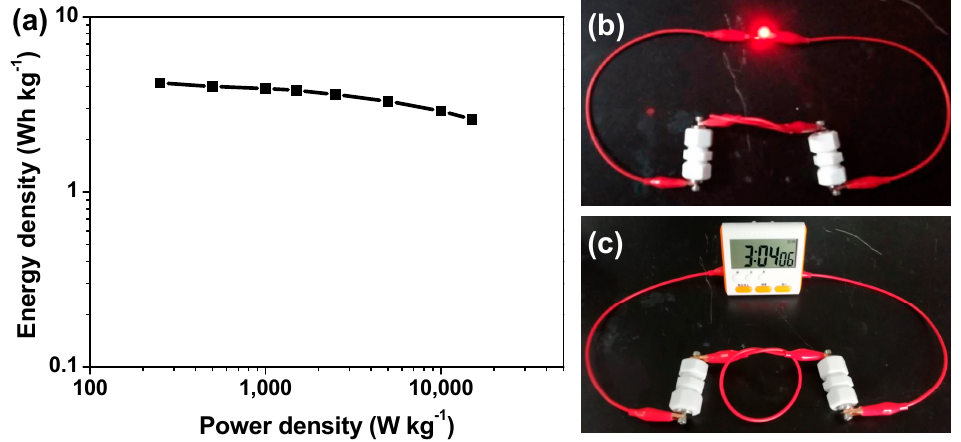
Figure 8. ( a ) Ragone plot of an as-assembled HPC-2//HPC-2 supercapacitor cell; ( b , c ) Digital photographs of a red light-emitting diode bulb and a portable timer well powered by two HPC-2//HPC-2 supercapacitor cells connected in series, respectively.